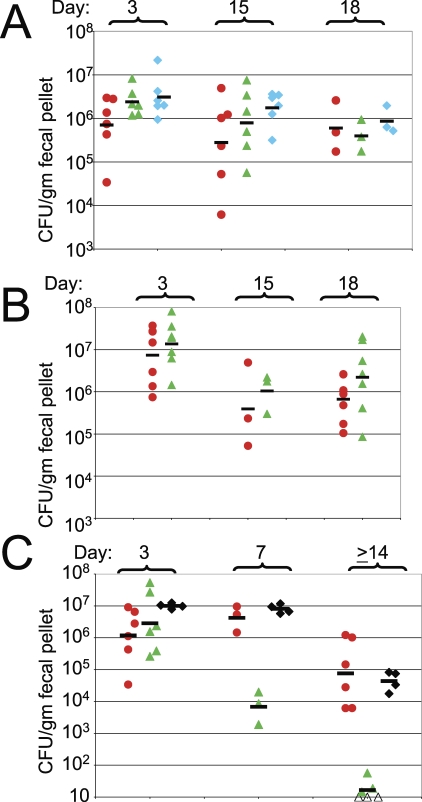

rbt1 and rbt4 Mutants Colonize the Murine Intestinal Tract at WT LevelsCells of WT strains DAY185 or F2U, rbt1 deletion mutant strain BCa 7–4, rbt4 null mutant strain BCa 11–3, ece1 null mutant CAW19–1, CKY362 (ECE1 reconstituted), and CKY376 (yhb1 yhb5 double null mutant) were orally inoculated by gavage. At various days post-inoculation, fresh fecal pellets were recovered from inoculated mice and the amount of C. albicans per gm was measured. Composite results of two experiments are shown. Different numbers of mice are shown on different days because some mice were sacrificed earlier and some mice were sampled on different days.(A) Red circles, DAY185 or F2U (WT) (six mice); green triangles, rbt1 deletion mutant strain BCa 7–4 (six mice); blue diamonds, rbt4 deletion mutant strain Bca 11–3 (six mice); bars, geometric means.(B) Red circles, DAY185 (WT) (six mice); green triangles, yhb1 yhb5 double null mutant strain CKY376 (six mice); bars, geometric means.(C) Red circles, DAY185 or F2U (WT) (six mice); green triangles, ece1 deletion mutant strain CAW19–1 (six mice); black diamonds, ECE1 reconstituted mutant strain CKY362 (four mice); bars, geometric means. Open symbols, no colonies detected. Day ≥ 14 indicates samples taken on day 14 or day 15.